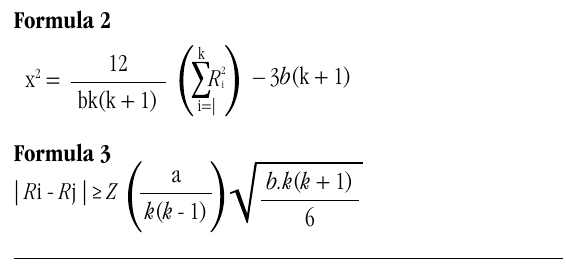
figurE 4 – Formulas cited in “Material and